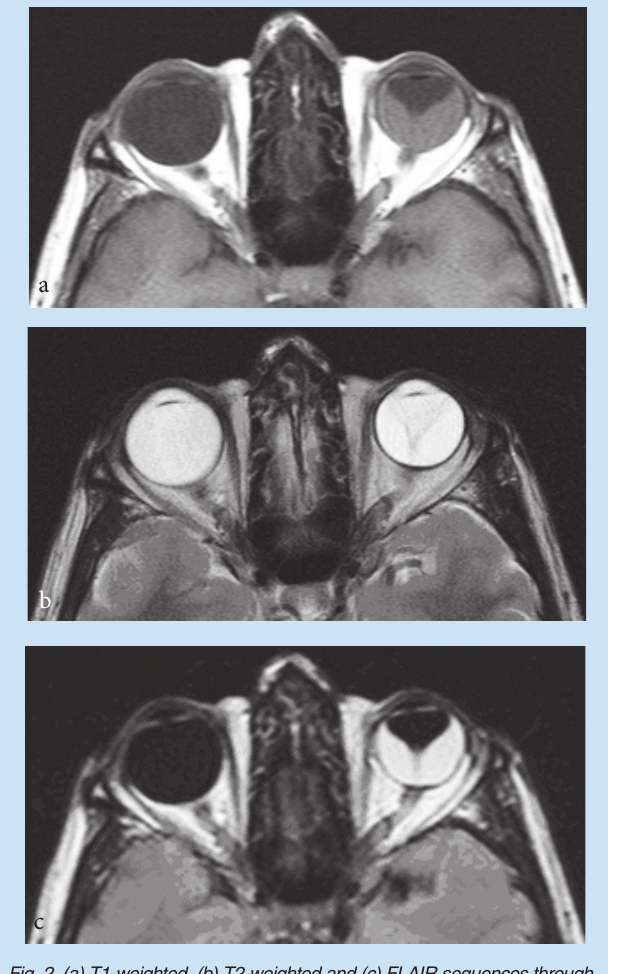
Fig. 2. (a) T1-weighted, (b) T2-weighted and (c) FLAIR sequences through the orbit. A ‘V’-shaped abnormal signal is present posteriorly in the left eye with its apex at the optic disc and the arms of the ‘V’ angled towards the ciliary body. Note signal increase in the space outside the ‘V’ on both T1-weighted and FLAIR sequences, in keeping with